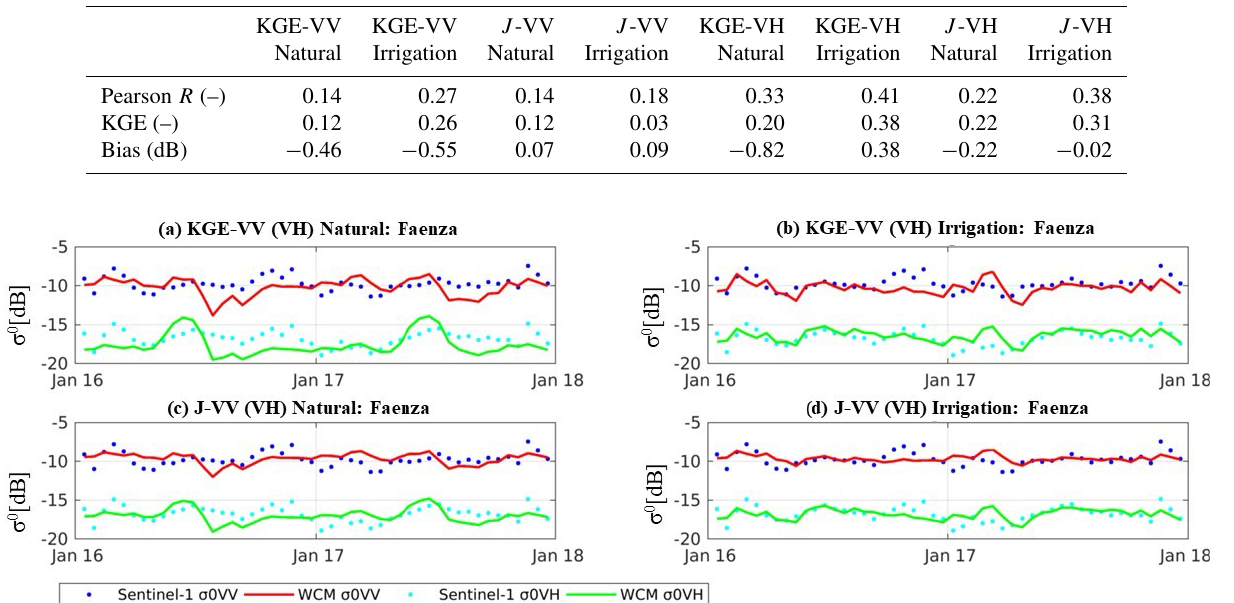
Figure 11. Comparisons between σ 0 observations (VV polarization in blue dots and VH polarization light blue dots) and simulations (VV polarization in red and VH polarization in green) in the Faenza (San Silvestro) field, after calibration with a KGE cost function for (a) the natural run, (b) the irrigation run, and after calibration with the J cost function for (c) the natural and (d) irrigation